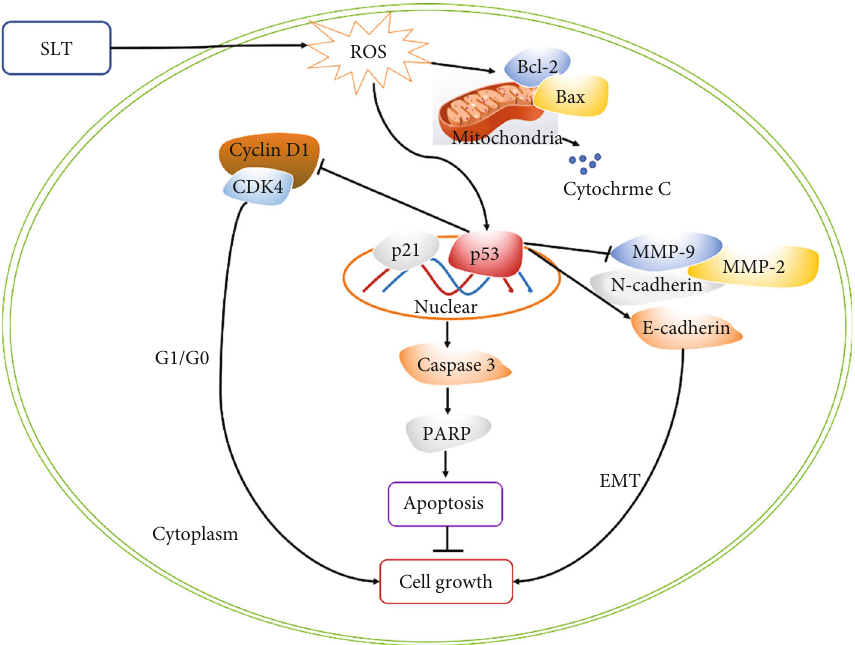
Figure 8: Schematic diagram of the potential molecular mechanism of anticancer e ff ects of SLT on ovarian cancer. → : activation; ⊥ :